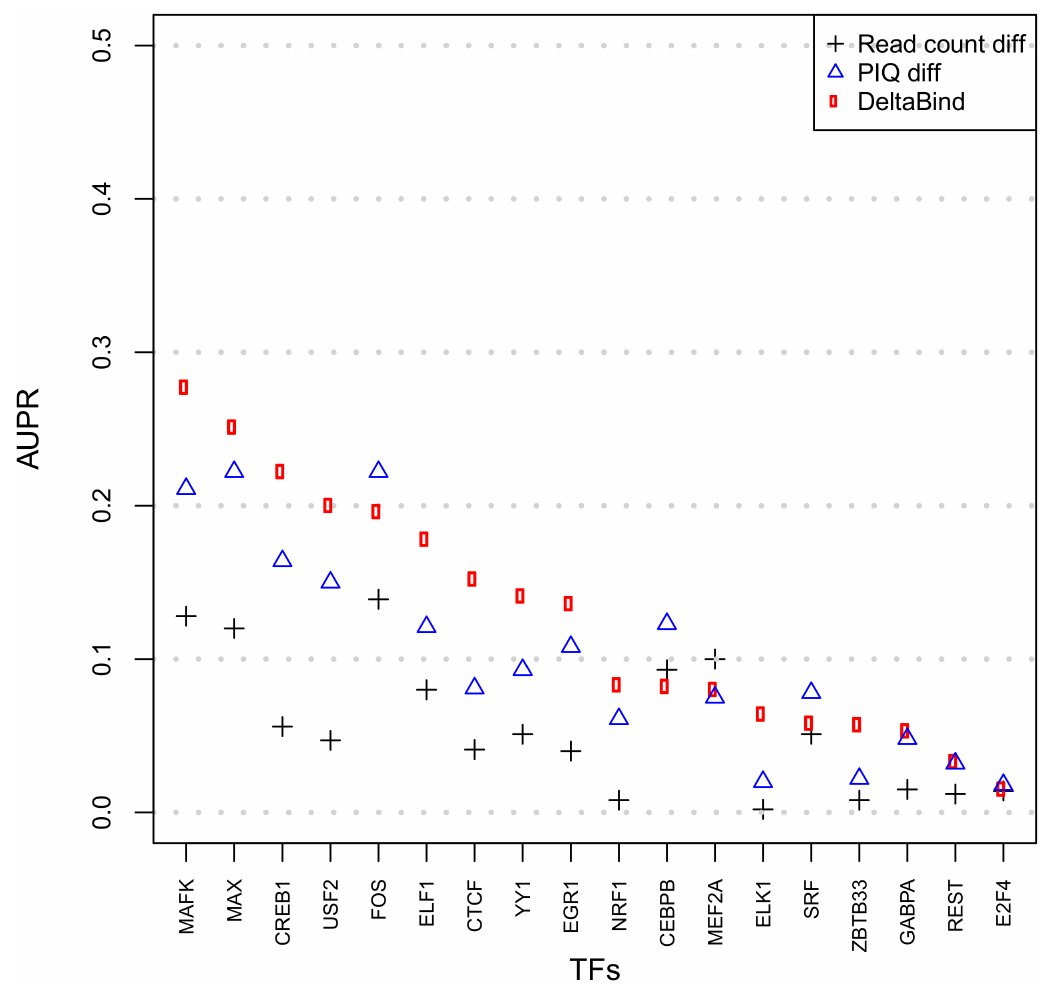
Fig 1. AUPR for 18 tested factors using 3 different